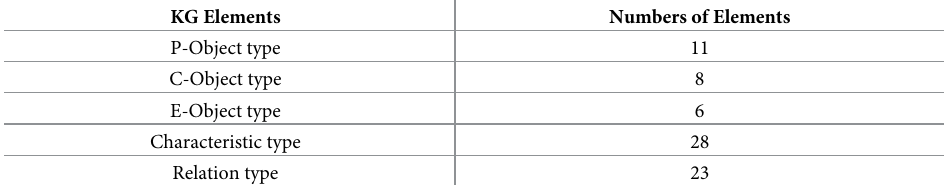
Table 5. Statistical of node types and relationship types of the constructed KG.